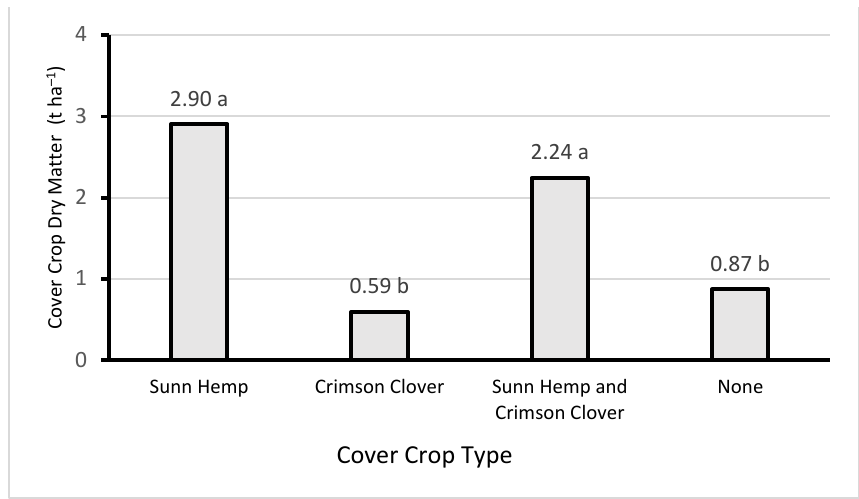
Figure 1. Mean aboveground cover crop biomass (t ha − 1 ) as a function of cover crop treatment. Means followed by the same letter are not significantly different from each other according to Bonferroni adjusted t -tests at p ≤ 0.05.